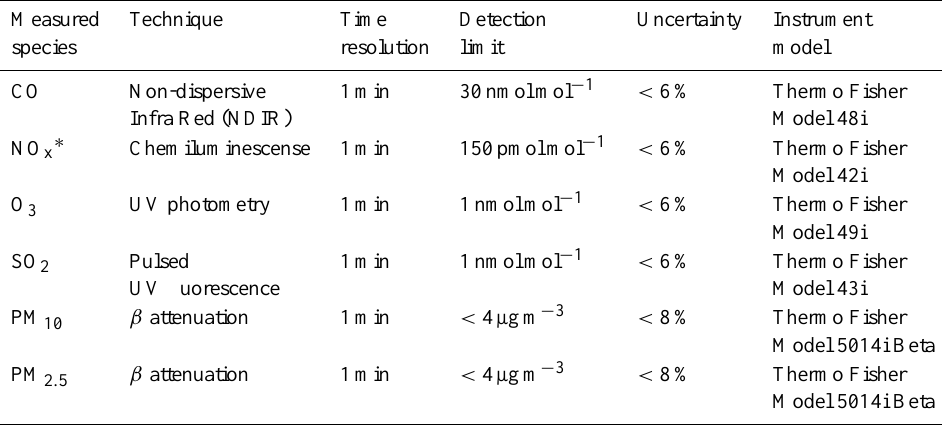
Table 2. Species measured at the IISER Mohali air quality station with respective technique, temporal resolution, detection limit, uncertainty and instrument model. Measured Technique Time Detection Uncertainty Instrument species resolution limit model CO Non-dispersive 1min 30nmolmol − 1 < 6% Thermo Fisher Infra Red (NDIR) Model 48i NO x ∗ Chemiluminescense 1min 150pmolmol − 1 < 6% Thermo Fisher Model 42i O 3 UV photometry 1min 1nmolmol − 1 Thermo Fisher Model 49i SO 2 Pulsed 1min 1nmolmol − 1 Thermo Fisher UV fluorescence Model 43i PM 10 β attenuation 1min Thermo Fisher Thermo Fisher Model 5014i Beta ∗ Refer to Sect. 2.2.3 for details of the NO x